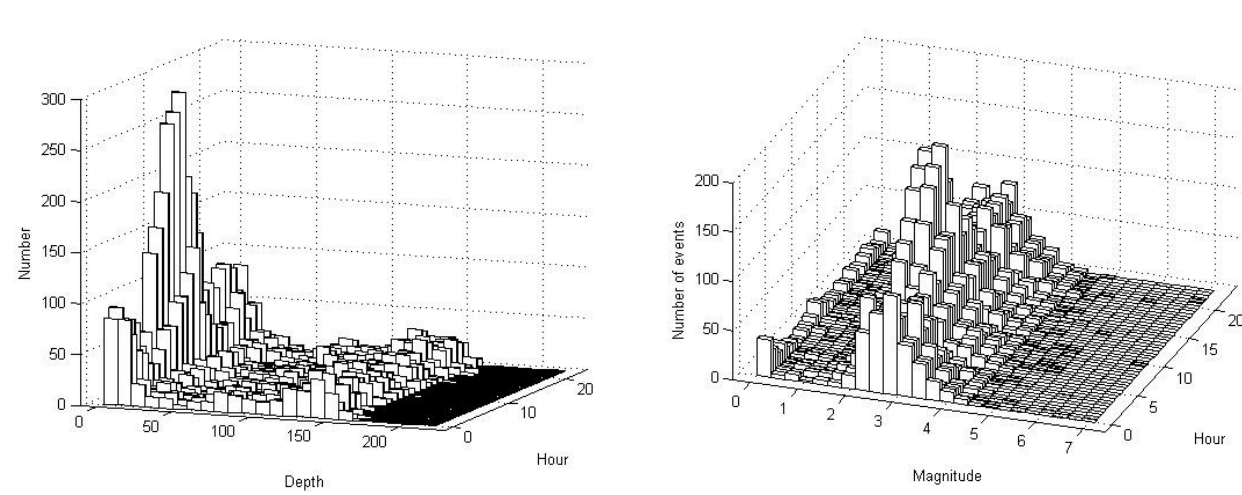
Fig. 3. Hour-depth distribution of Vrancea earthquakes. Fig. 4. Hour-magnitude distribution of Vrancea